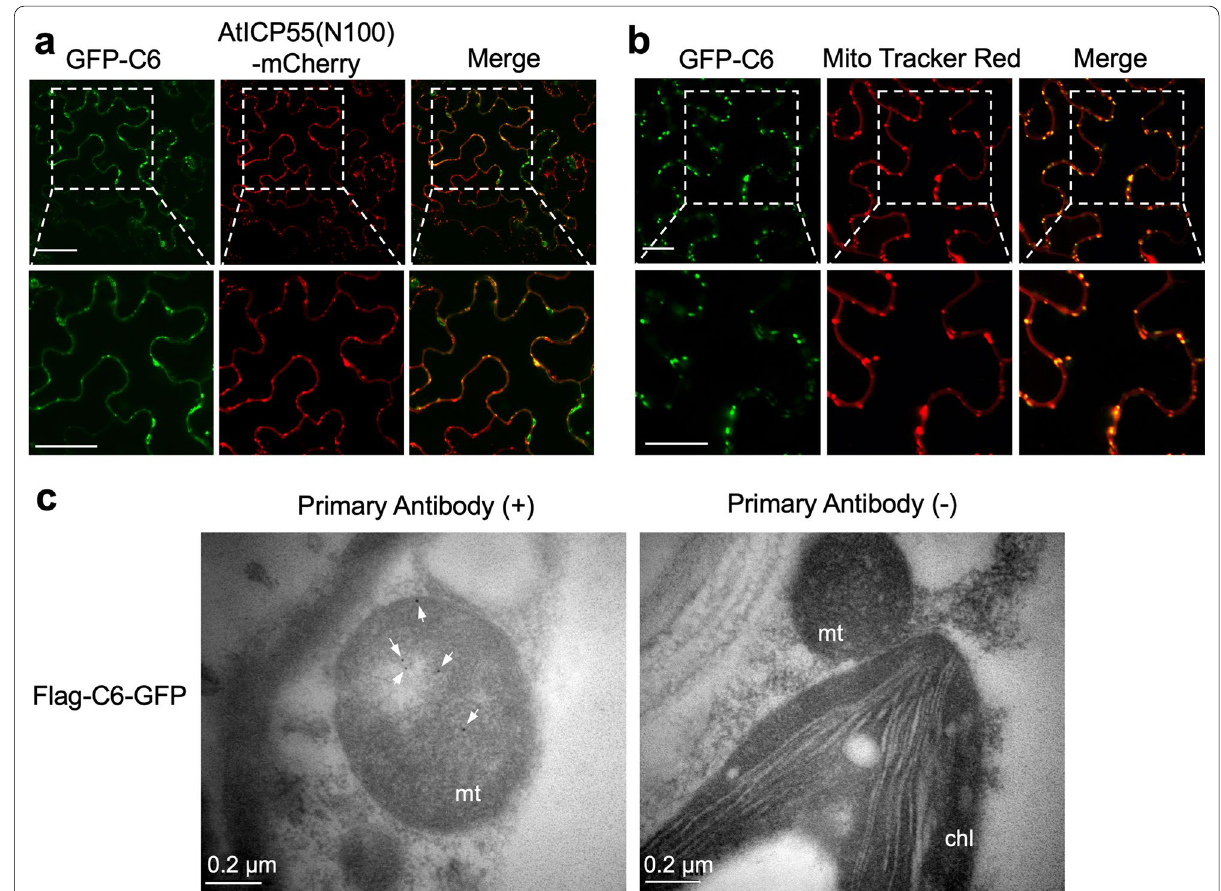
marker AtICP55(N100)‑mCherry in mesophyll cells of N. benthamiana leaves. Scale bars: 25 μm. b Co‑localization of GFP‑C6 with the mitochondrial stain Mito Tracker Red. Scale bars: 25 μm. c Immunogold staining of Flag‑C6‑GFP protein in N. benthamiana mesophyll cells with (left panel) or without (right panel) GFP antibody. Arrows indicate gold label in the mitochondrion. Scale bars: 0.2 μm. Mt: mitochondrion. Chl: